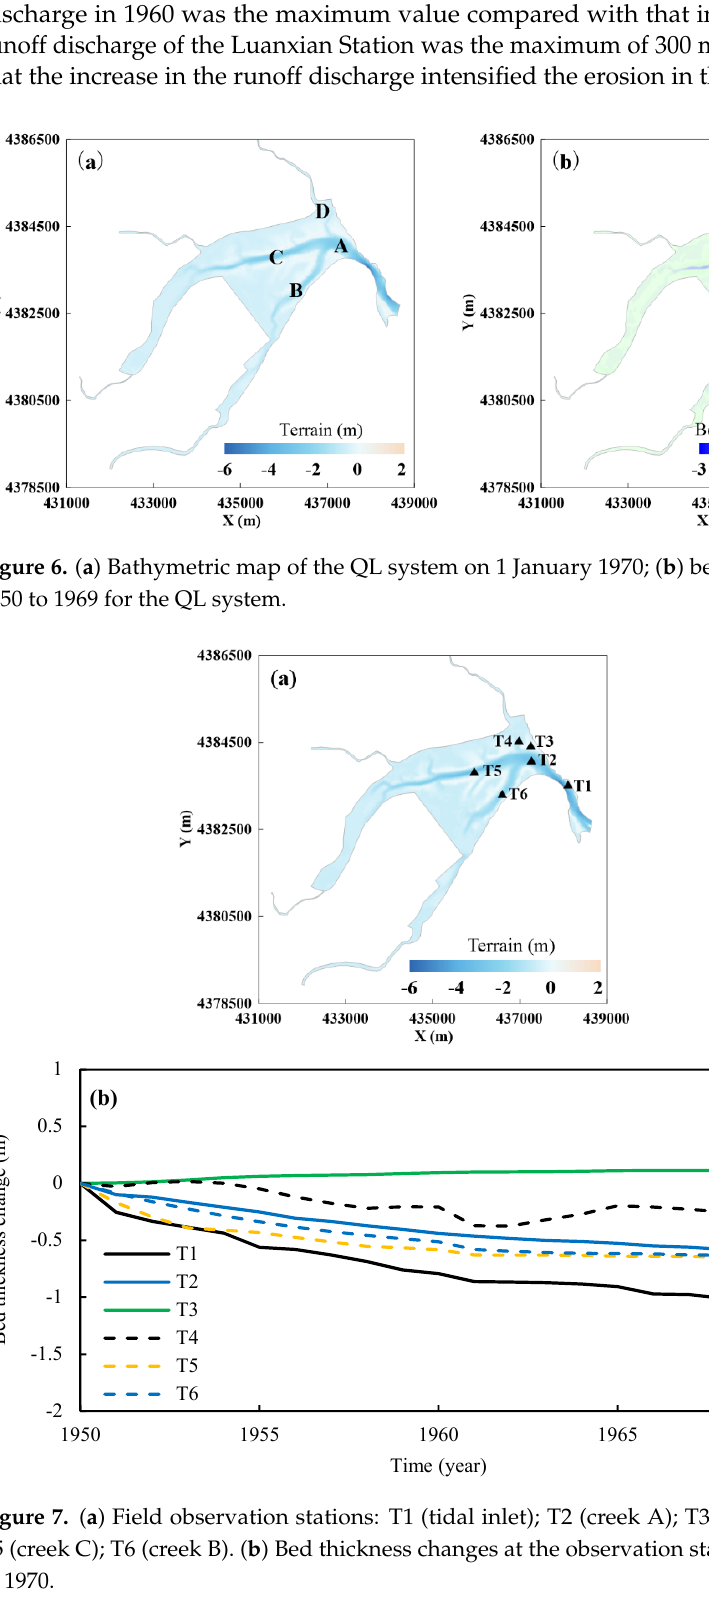
Figure 6. ( a ) Bathymetric map of the QL system on 1 January 1970; ( b ) bed thickness change from 1950 to 1969 for the QL system.